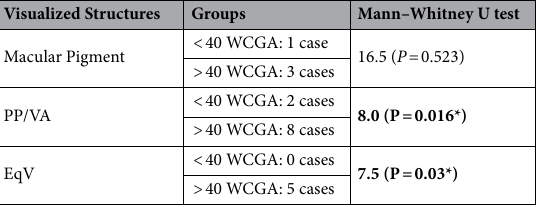
Table 2. Comparison of visualized structures < 40 WCGA vs. > 40 WVGA. WCGA weeks of corrected gestational age, PP/VA peripapillary/vascular arcades, EqV equatorial vessels. Statistical significance , P < 0.05.